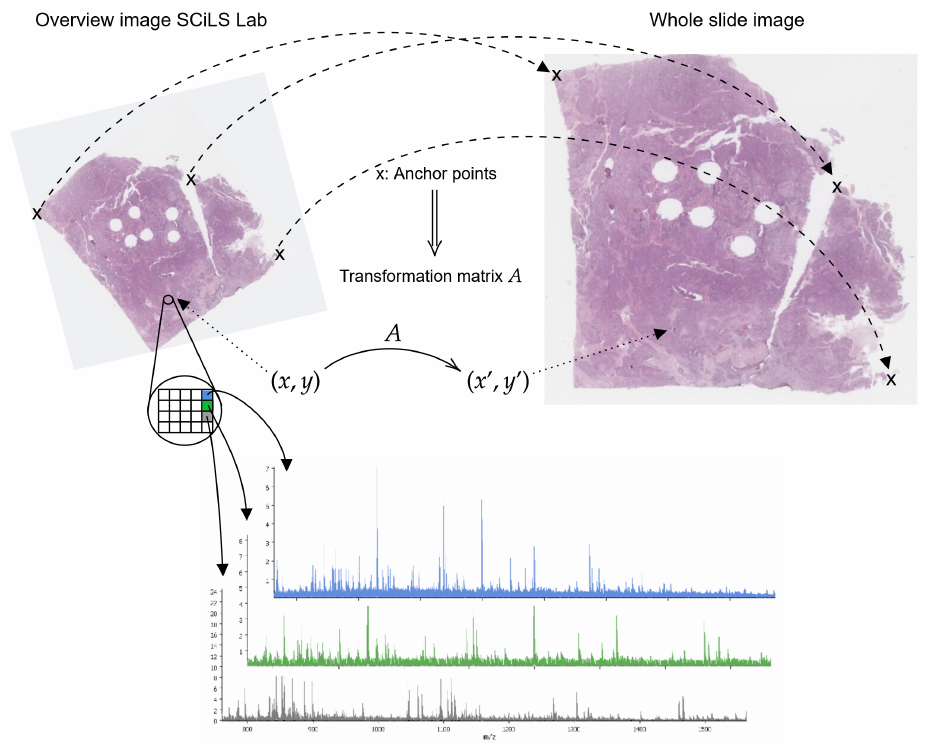
Figure A3. Sketch of image registration process. Anchor points (x) are used to compute transfor- mation matrix A , which maps SCiLS Lab coordinates ( x , y ) to coordinates of whole slide images ( x (cid:48) , y (cid:48) ) .